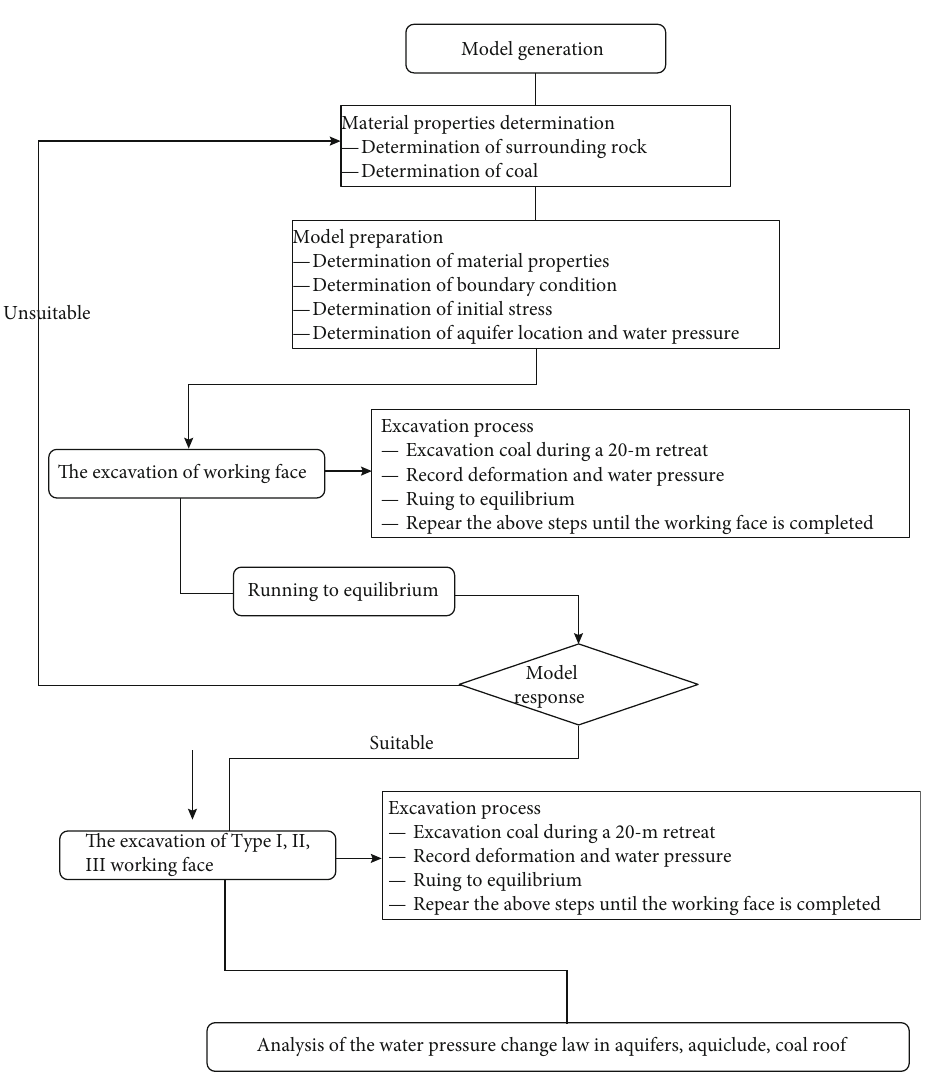
Figure 3: Flow chart of numerical simulation. Table 1: Physical and mechanical parameters of rock